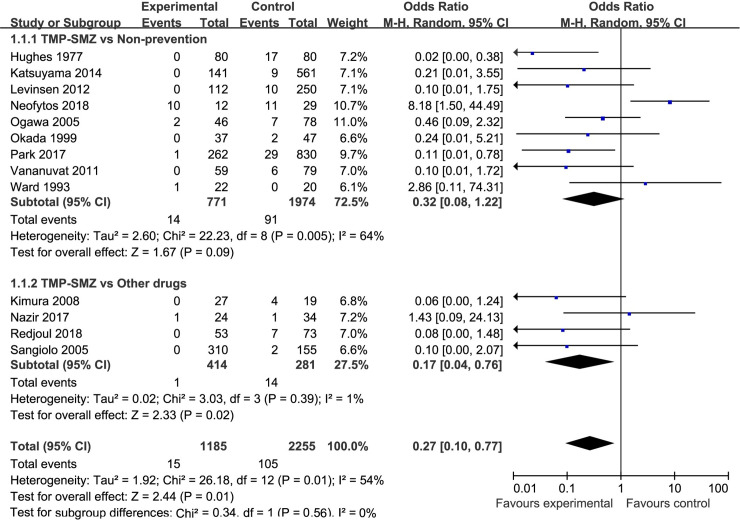
Forest plot of the incidence rate of PCP incidence.The vertical line indicates no difference between the groups. ORs are represented by diamonds, and 95% CIs are depicted by horizontal lines. Squares indicate point estimates, and the size of each square indicates the weight of the given study in the meta-analysis. M-H, Mantel-Haenszel random-effects model.